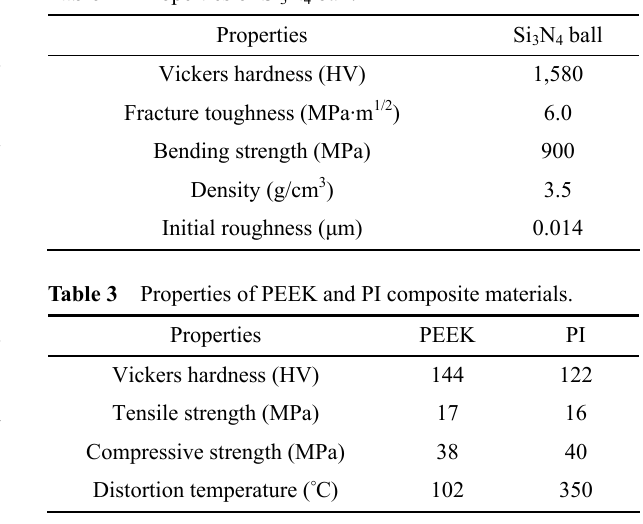
Table 2 Properties of Si 3 N 4 ball.